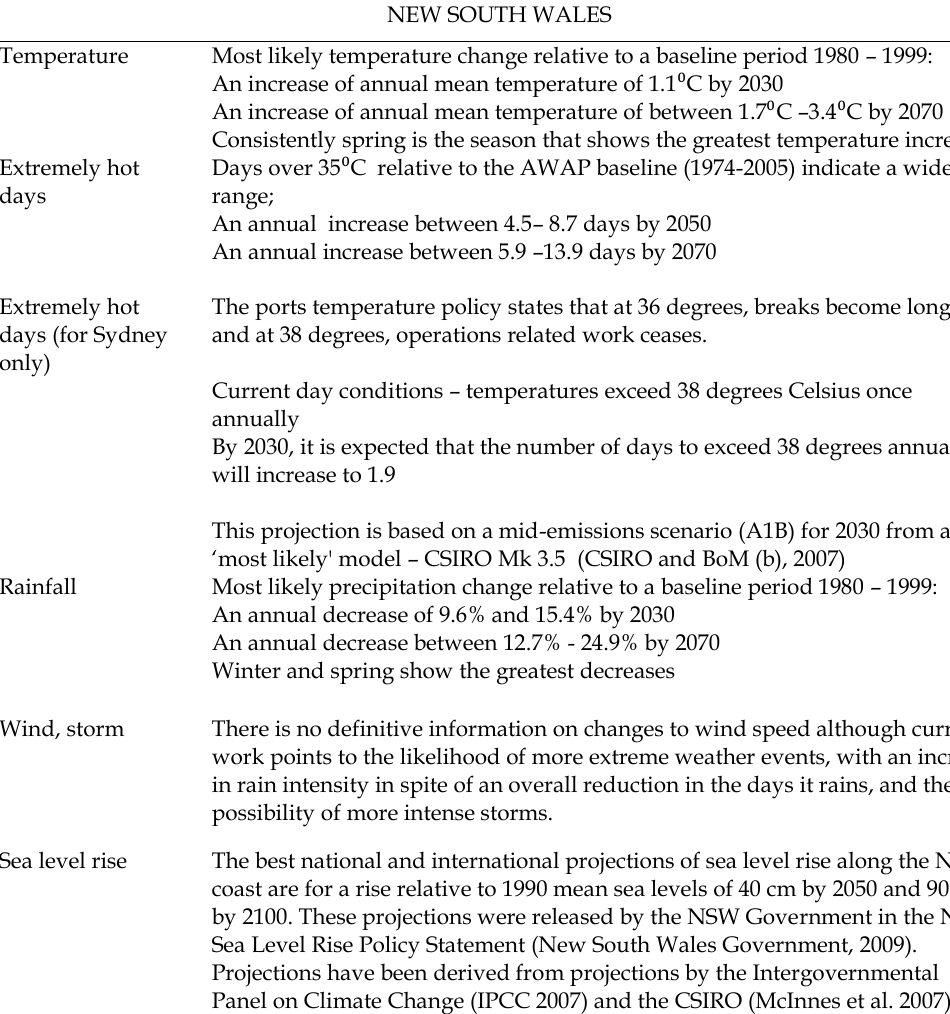
Table 6. Climate data summary for NSW,